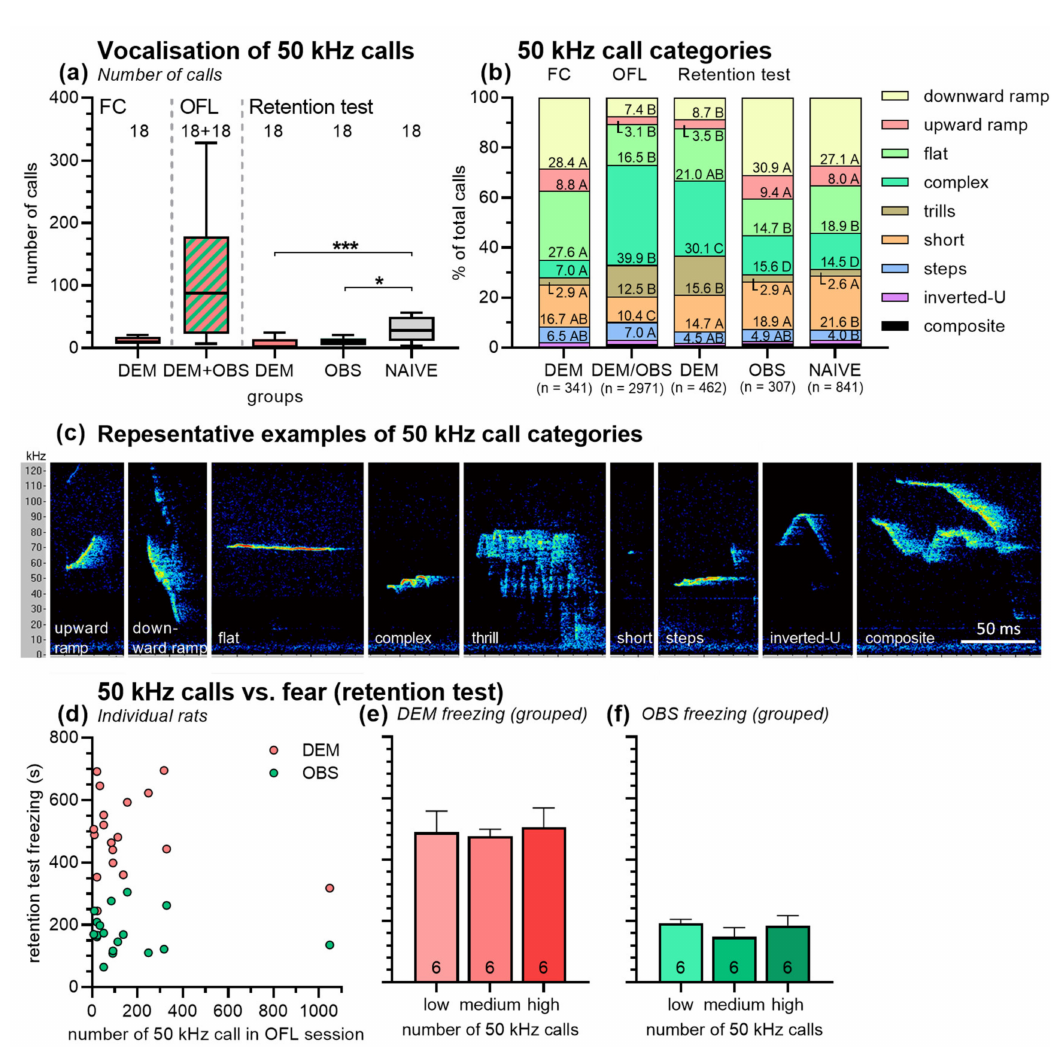
Figure 5. ( a ) Number of 50 kHz calls in the different phases of the experiment. Most 50 kHz calls were emitted in the observational fear learning session in which two rats were present. In the retention test, NAIVE rats emitted more 50 kHz calls than DEM and OBS rats. ( b ) 50 kHz call category profiles in the different sessions. The different colors of the bar sections indicate the different 50 kHz call categories. The numbers in the sectors represent the percent number of calls in a given category, related to the total number of calls in the respective session (indicated on the bottom). The letters after the number indicate whether the proportion of a call category differs across the sessions ( χ 2 test). Different letters symbolize significantly different proportions; equal letters stand for non-significant proportions. ( c ) Representative examples of the different 50 kHz call categories. ( d ) Freezing behavior of DEM and OBS rats in the retention session as a function of the number of 50 kHz calls in the observational fear learning session. No correlations were found. ( e , f ) Therefore, the observational fear learning sessions were grouped into sessions with low, medium, and high number of 50 kHz calls. No effects of 50 kHz calls on the freezing behavior of DEM and OBS rats in the retention test were found. Y -axis scale and units in panels ( e , f ) are the same as in panel ( d ). Abbreviations: DEM, demonstrator rats; FC, fear conditioning session; OBS, observer rats; OFL, observational fear learning session; NAIVE, naive rats. Numbers in the bars or above the boxes indicate group and subgroup sizes. *** p < 0.001, * p < 0.05; comparisons as indicated, after significant main effects in Kruskal–Wallis